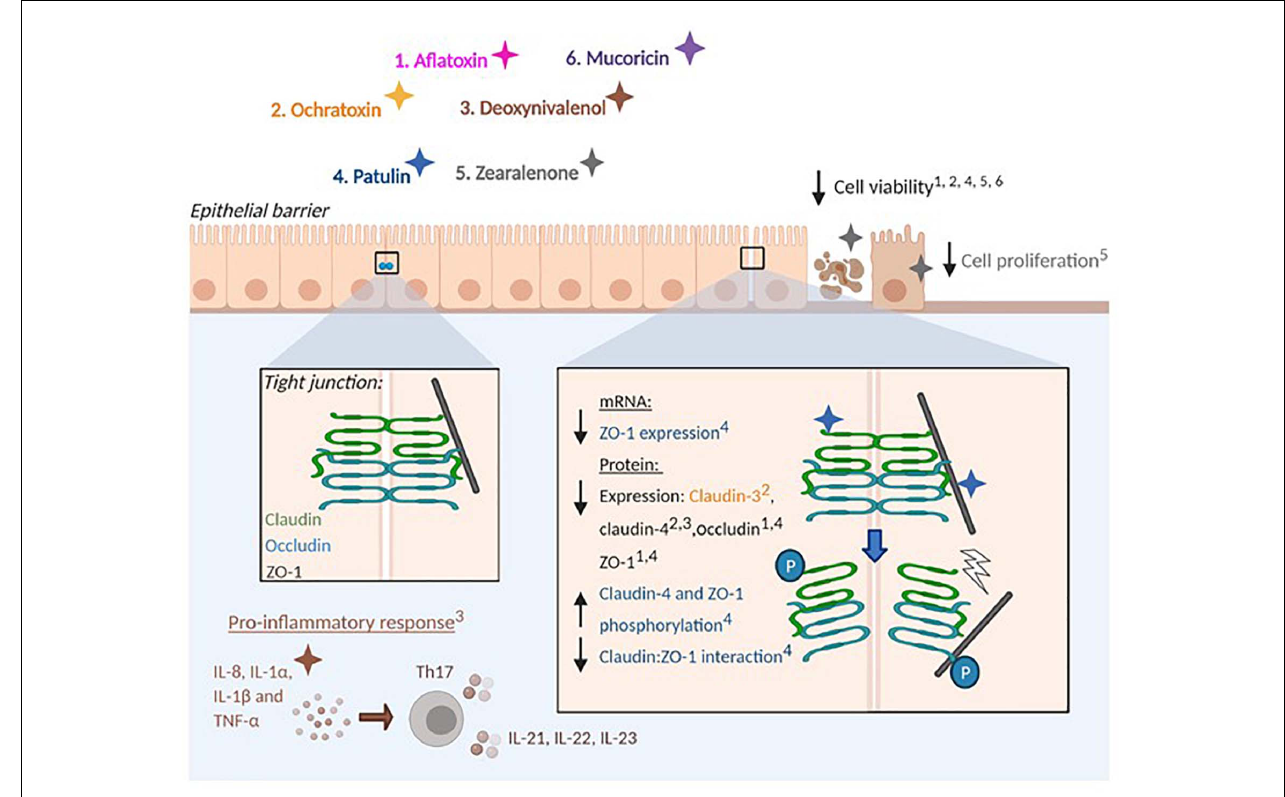
FIGURE 3 | Effect of mycotoxins and protein toxins on barrier integrity. Fungal toxins that influence epithelial barrier integrity are represented by colours: 1. Aflatoxin (pink), 2. Ochratoxin (orange), 3. Deoxynivalenol (brown), 4. Patulin (blue), 5. Zearalenone (grey). 6. Mucoricin (purple). Mycotoxins impair epithelial barrier integrity by altering the production of tight junction proteins (Claudins, Occludin and Zonula occludens-1) by epithelial cells. Arrows denote the promotion or reduction of indicated processes. Numbers in superscript identify processes affected by specific toxins. Protein phosphorylation is indicated (P). Mycotoxins also stimulate pro-inflammatory responses at mucosal surfaces and impair barrier integrity in a tight junction-independent manner by reducing cell viability and proliferation.